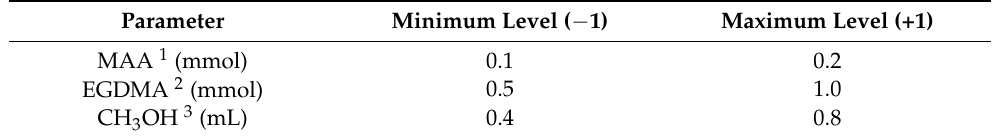
Table 2. Optimization of the prepolymeric mixture by a Full Factorial Design 2 3 : level definitions for the parameters considered, keeping constant the Irbesartan content (0.05 mmol).